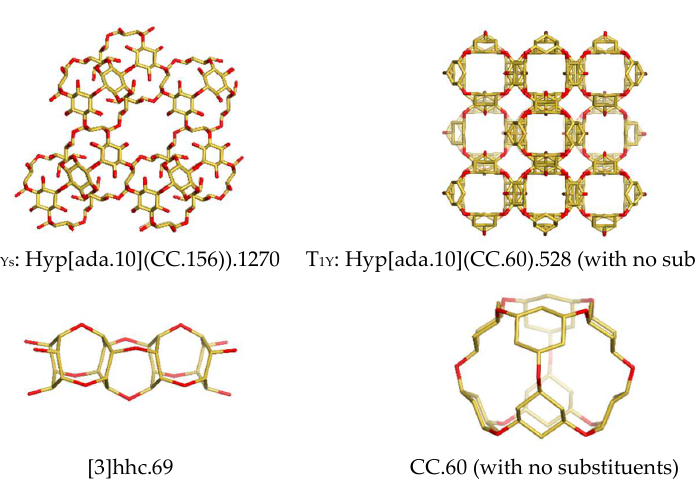
Figure 6. Hyper-adamantane (left, top), the unit of a triple periodic diamondoid net; a rod-like etheric relative (left, bottom) and the building blocks of the triple periodic net (with no substituents - the right column).